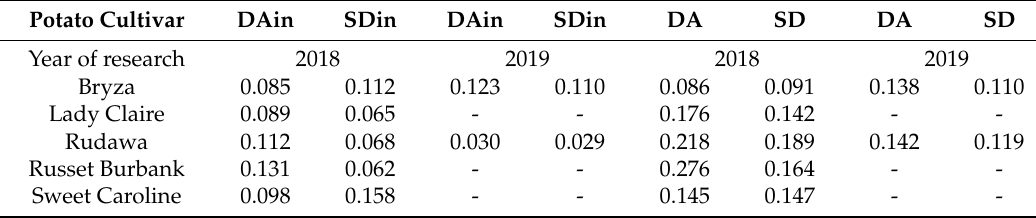
Table 1. Drop asymmetry of potato leaf surface calculated for 1 s (DAin) and for all 120 s (DA) for the potato cultivars examined in the years 2018 and